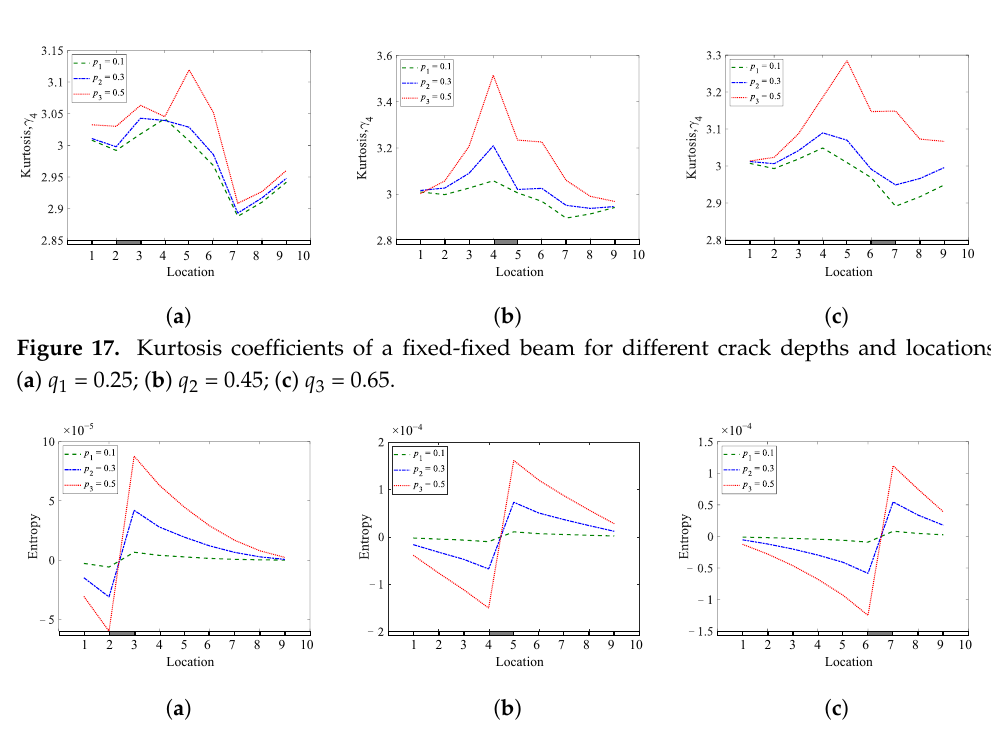
Figure 18. Entropy of a fixed-fixed beam for different crack depths and locations: ( a ) q 1 = 0.25; ( b ) q 2 = 0.45; ( c ) q 3 = 0.65.